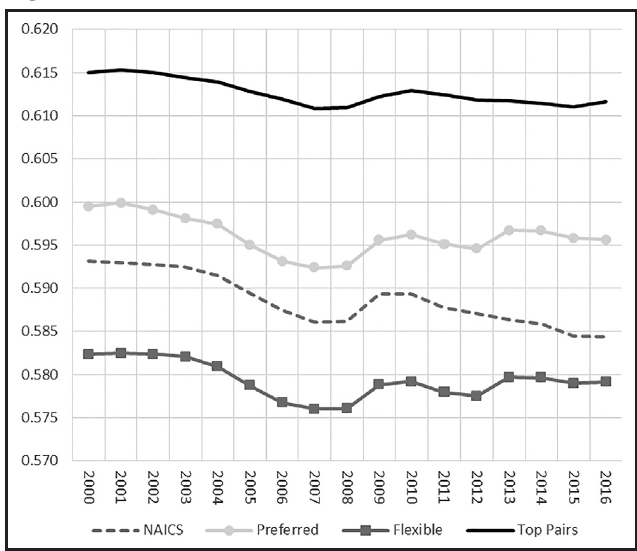
Figure 2 Evolution of the HHI in the United States: